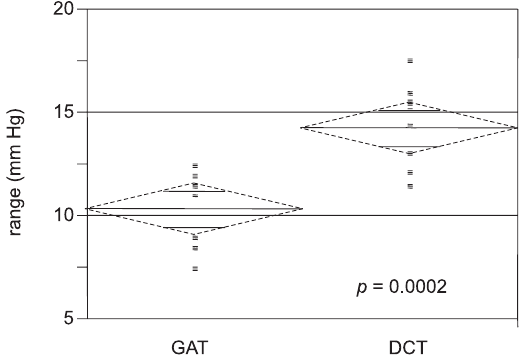
Figure 2 - The difference of mean intraocular pressure (IOP) readings by Goldman applanation tonometry (GAT) and dynamic contour tonometry (DCT) for group